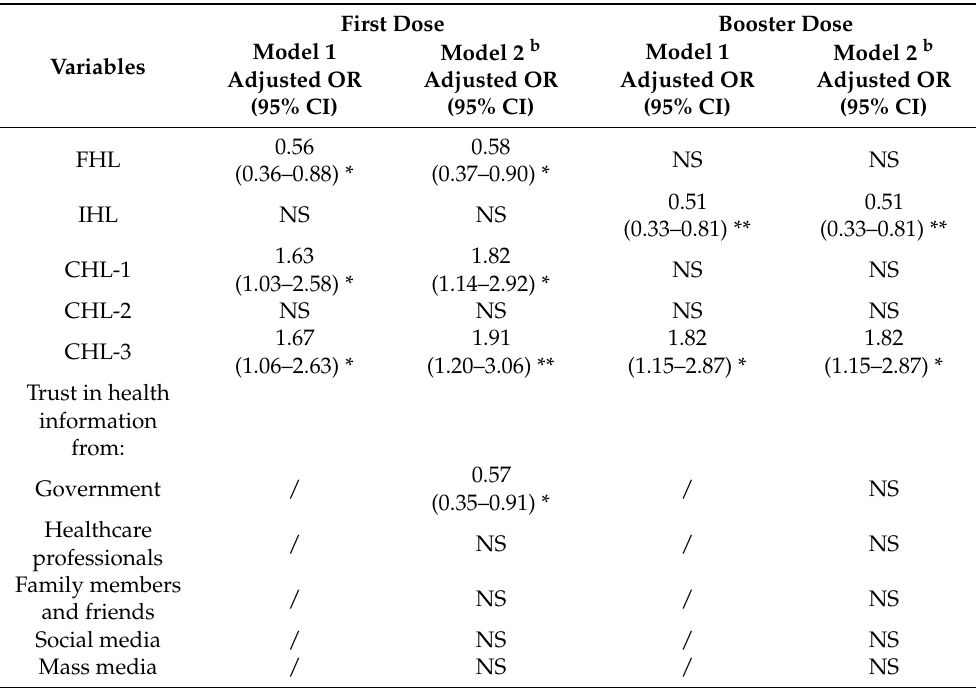
Table 3. The associations among HL, trust, and COVID-19 vaccine hesitancy estimated from the multivariable logistic regression model a